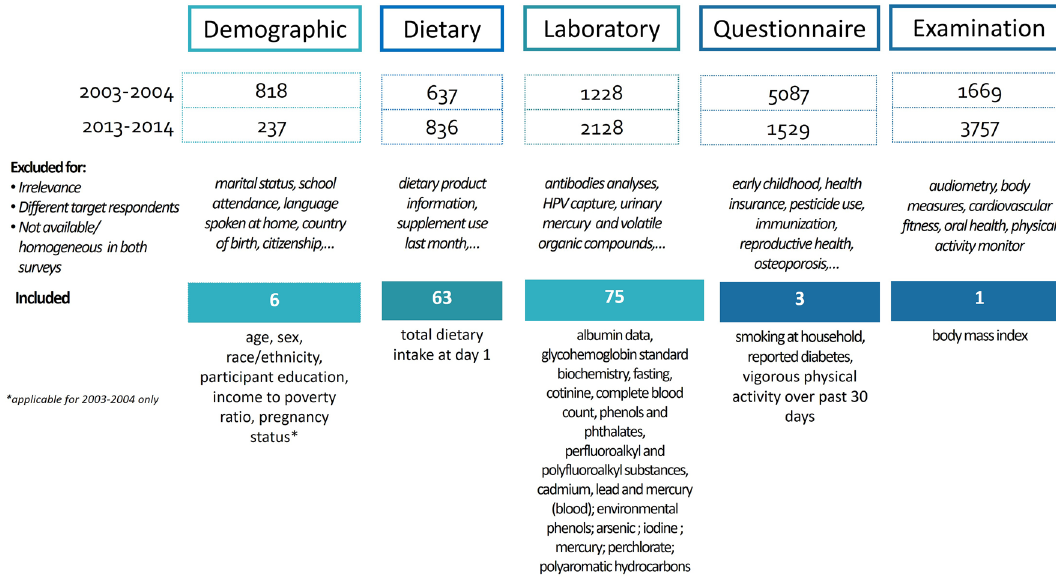
Figure 1. Initial selection of exposome variables from 2003–2004 and 2013–2014 NHANES